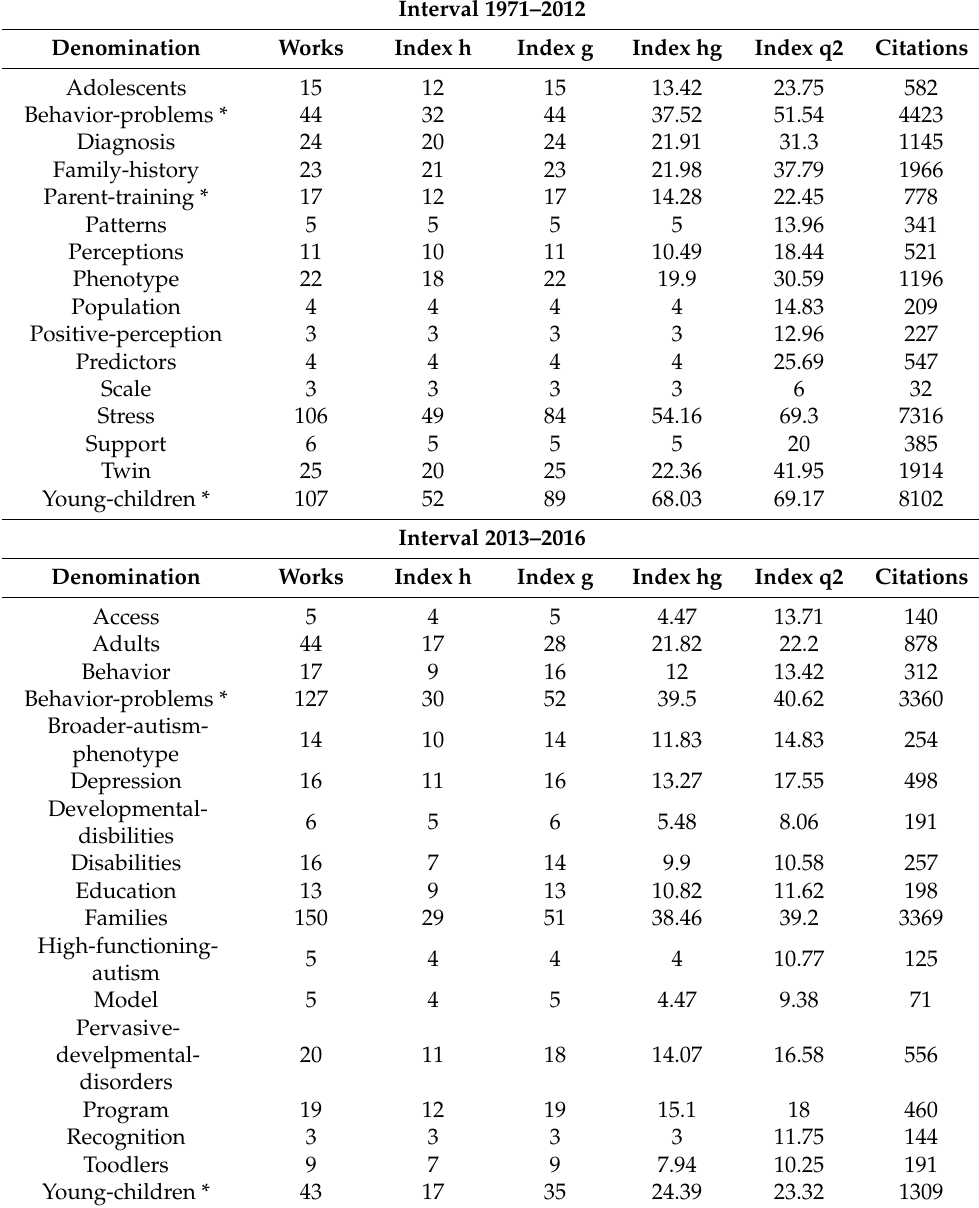
Table 10. Thematic performance in